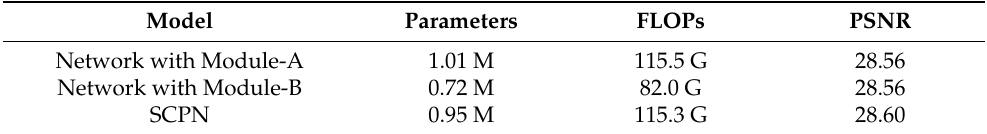
Figure 7. The structure of Module-A and Module-B. Table 1. The comparison of complexity and performance on Set14 by the contestants with upscale factor 4. FLOPs denote the number of floating-point